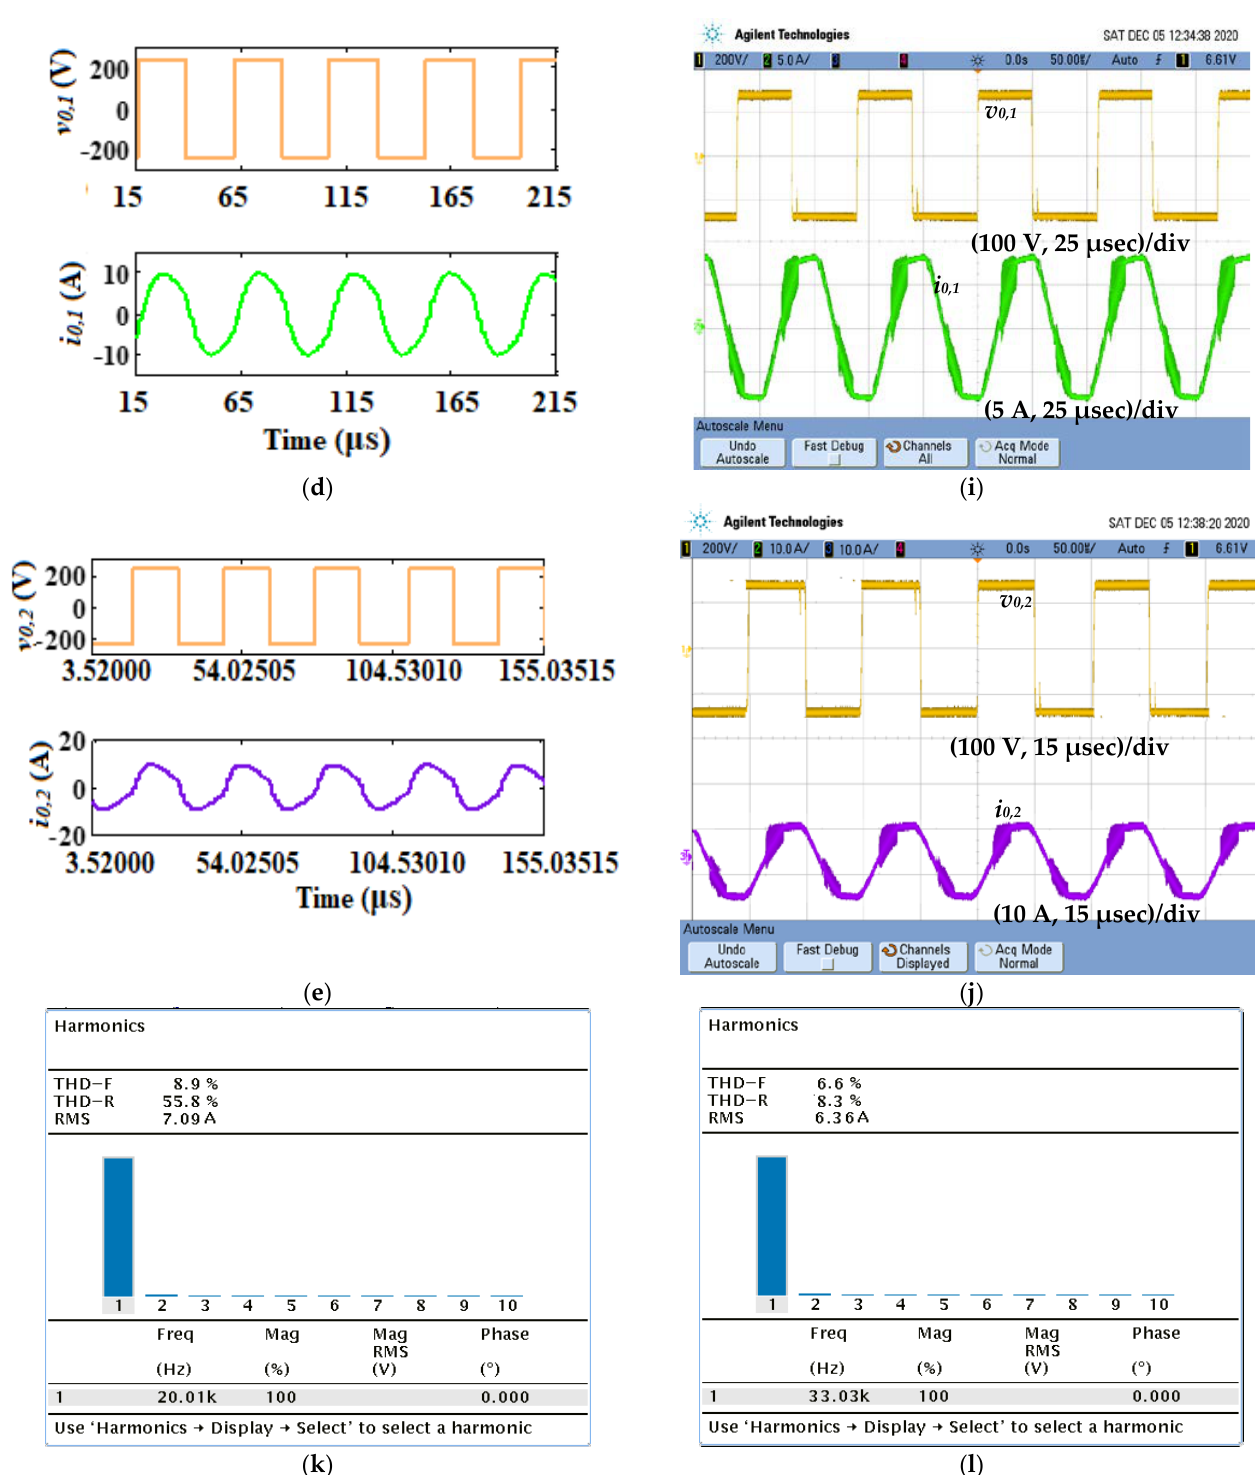
Figure 7. Main waveforms for 100% D PDM : simulation waveforms ( a ) switching pulses, ( b ) output voltage and current of load 1, ( c ) output voltage current of load 2, ( d ) zoomed view of the output voltage current of load 1, ( e ) zoomed view of the output voltage current of load 2, experimental waveforms ( f ) switching pulses, ( g ) output voltage and current of load 1, ( h ) output voltage current of load 2, ( i ) zoomed view of the output voltage current of load 1, ( j ) zoomed view of the output voltage current of load 2, ( k ) current spectrum of load 1, ( l ) current spectrum of load 2.